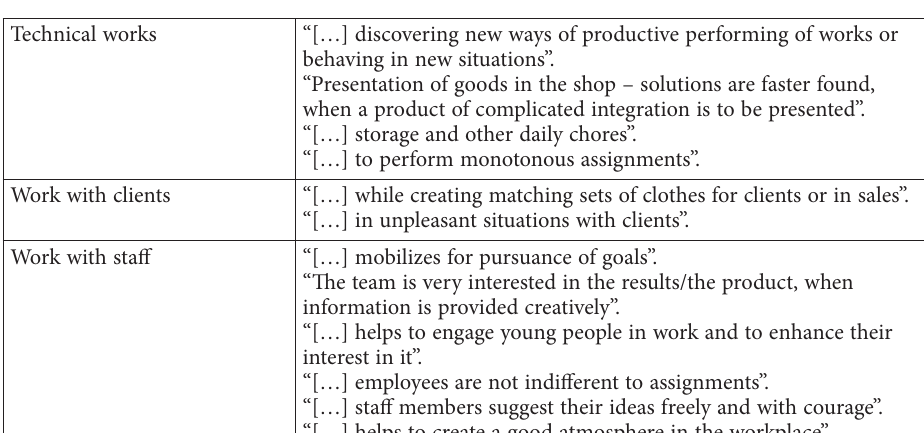
Work with clients Work with